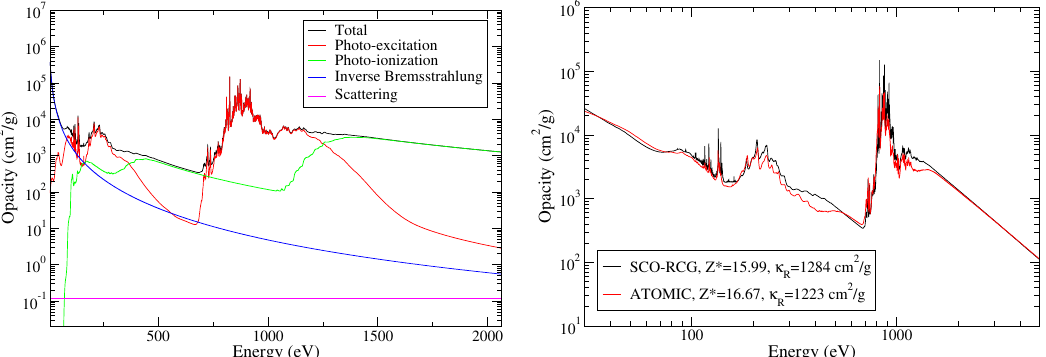
Figure 8. Different contributions to the opacity of iron calculated with SCO-RCG at conditions of the boundary of the convective zone ( left ), i.e., T = 192.91 eV and n e = 10 23 cm − 3 , and a comparison between the present SCO-RCG and ATOMIC total opacities [39,40] at the same conditions ( right ). The ATOMIC calculations were kindly provided by J. Colgan. The OP Rosseland mean at these conditions is much lower and equal to 854 cm 2